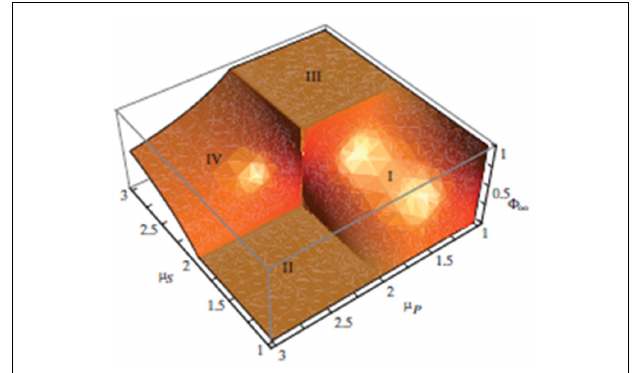
FIGURE 1 |The cross-correlation cube. The asymptotic cross-correlation function defined by Eq. 3 is graphed as a function of the two power–law indices of the perturbed network S and the perturbing network P . (From West and Grigolini, 2011, with permission.)